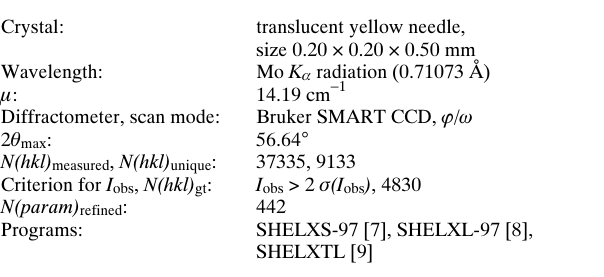
Table 1. Data collection and